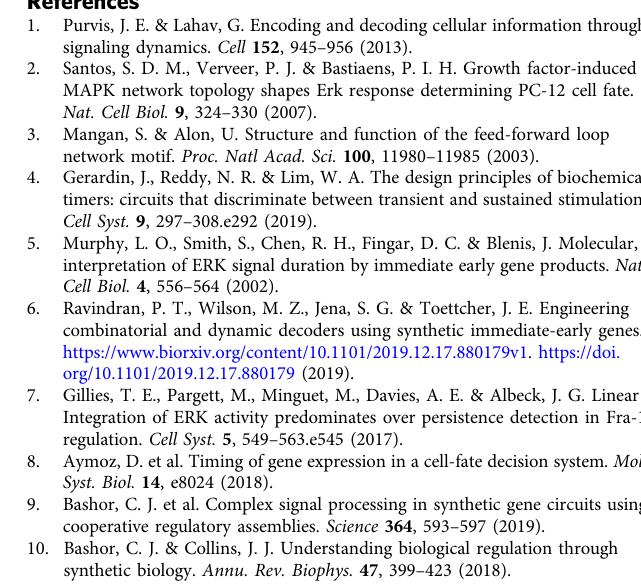
(Zymo Research). We performed qRT-PCR on a LightCycler 480 Instrument using the PowerUp SYBR Green Master Mix (ThermoFisher) with primers listed in Supplementary Table 5. We fi tted all fl uorescence curves with the fi ve-parameter logistic curve from 39 and used the analytical solution of the second derivative maximum to determine the Ct values. For copy number quanti fi cation, we used citrine (always present as one copy) as an internal reference and we used the strain yCL110 (containing one copy of each target) as a reference strain. Primer ef fi - ciencies E LexA , E Citrine , and E TetR were estimated with calibration curves, and copy numbers were estimated as in Pfaff et al. 40